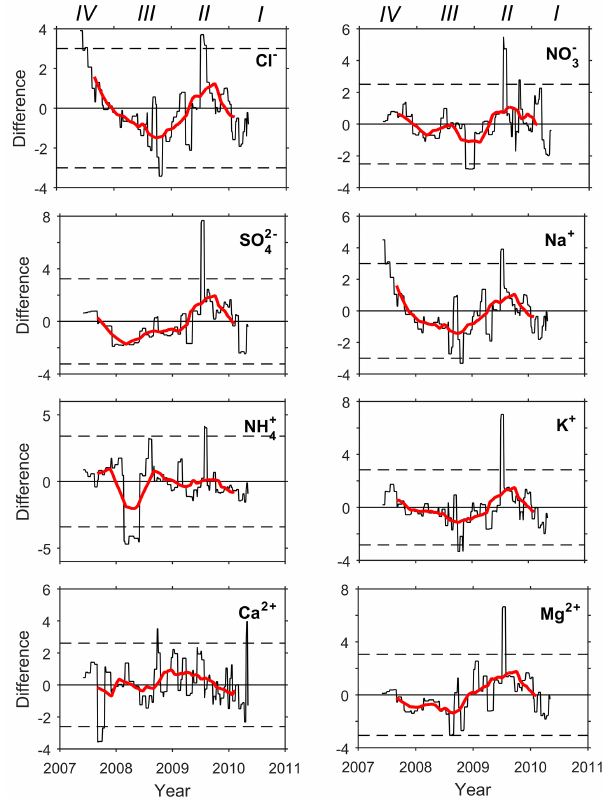
Figure 8. Difference between the normalized ionic concentrations ( c N ) in the LF-11 and the LF-syn ice cores (black line). Twice the standard deviation (dashed black line) and zero values (horizontal line) are also shown. Deposition is a positive excursion and elution zones are negative excursions from the mean in each diagram. A low-pass filter (half-year moving average) is shown in red. Differ- ent periods of deposition and elution have been noted with Roman